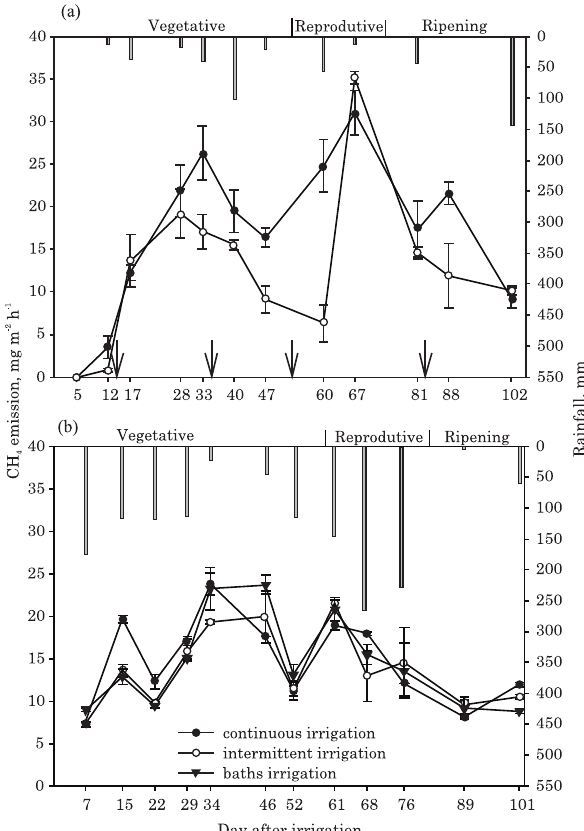
Figure 1. Methane efflux in different irrigation systems (lines and symbols) and rainfall (top bars) in each sample during 2007/08 (a) and 2009/ 10 (b) growing seasons. Vertical lines indicate standard mean deviation and arrows indicate moments when water sheet is no longer